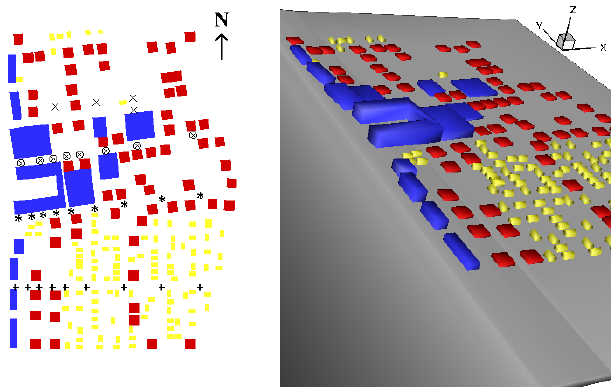
Figure 6. Layout of all buildings and gauges in the experiment: blue, large hotels or commercial buildings; red, smaller commercial buildings; yellow, residential structures. + : gauge A1–A9; ∗ : gauge B1–B9; ⊗ : gauge C1–C9; × : gauge D1–D4.